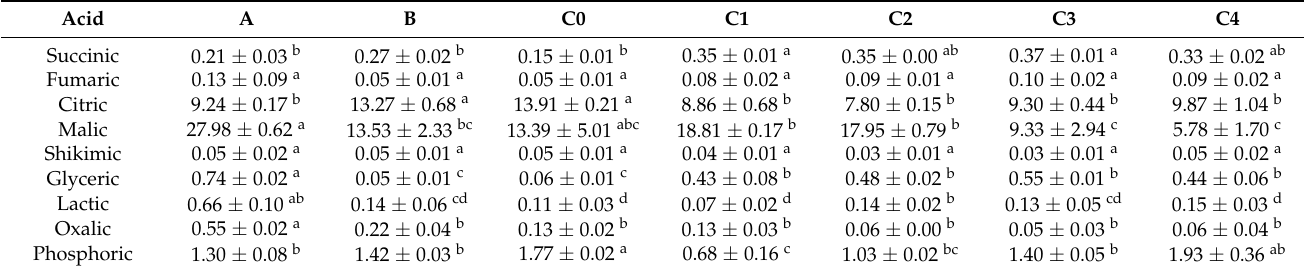
Table 6. Effect of methyl jasmonate (JA-Me) applied in lanolin paste on the middle part of the detached leaves of K. blossfeldiana on acid content. A—leaves on the plant; B—leaves detached from plant and kept in the inverted position for 4 days; D0—leaves kept in the inverted position and treated with pure lanolin; D1, D2, D3, and D4—leaves kept in the inverted position and treated with 1% JA-Me, 0.5% JA-Me, 0.25% JA-Me, or 0.1% JAMe in lanolin paste, respectively. Mean results in rows ± standard deviation followed by the same letter were not significantly different ( p < 0.05) according to Tukey’s